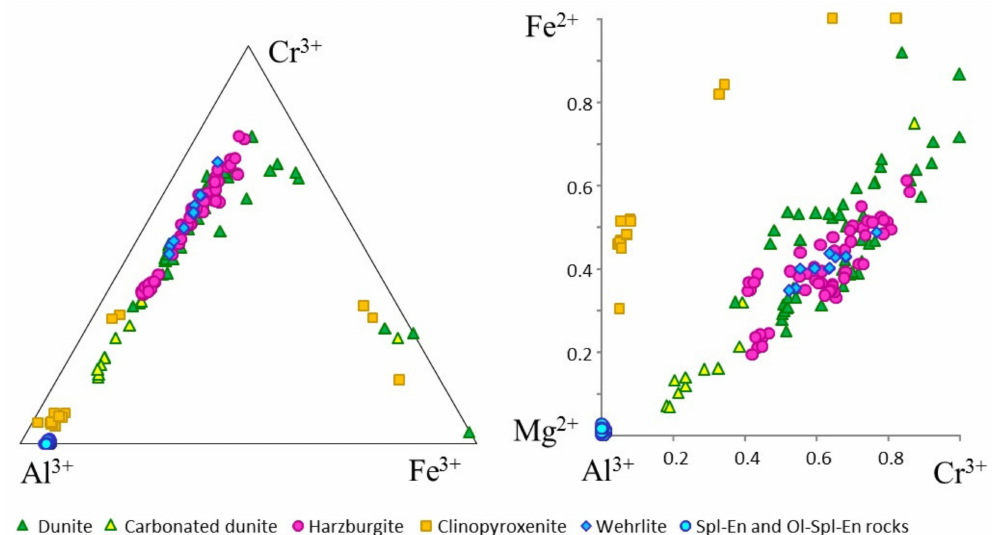
Figure 9. Chromite and spinel from the Olkhon